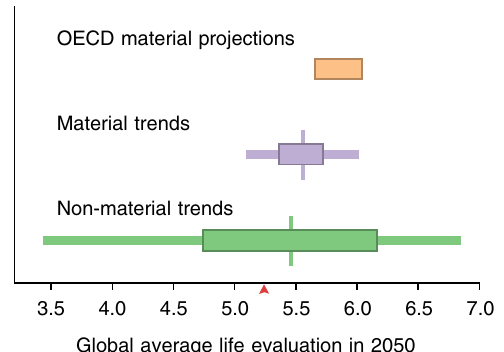
Fig. 2 Projected feasible life evaluations in 2050 scenarios. The results of two sets of material scenarios are shown for the year 2050, based on macroeconomic projections (OECD, orange) and recent trends (purple), as well as a set of non-material scenarios based on recent trends (green). The central vertical lines indicate projections based on the median trends, the thick horizontal bar indicates the range based on the 30th to 70th %ile trends, and the thinner horizontal bar indicates the range based on the 10th to 90th %ile trends. Outcomes are calculated with coef fi cients from the 2P model and are weighted by projected population sizes to aggregate across countries. The red arrow indicates the population-weighted average life evaluation recorded in